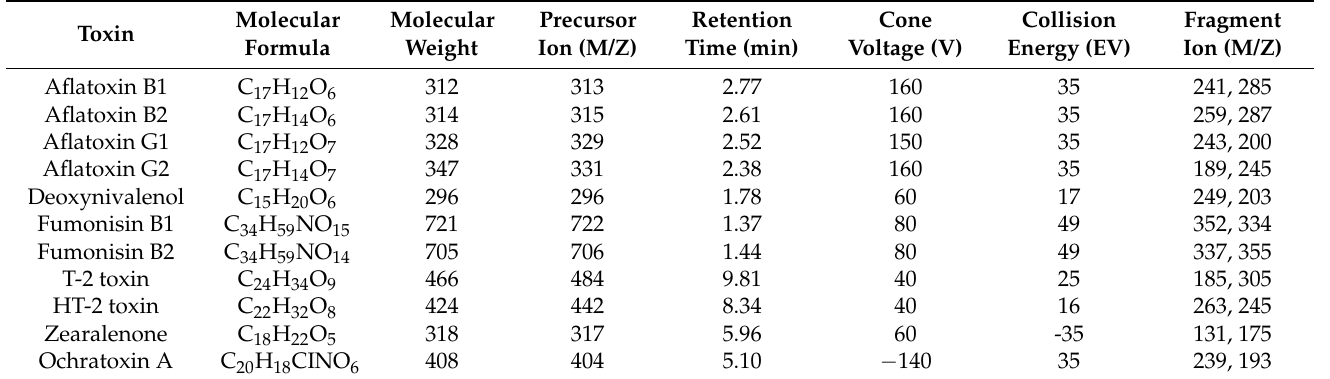
Table 3. Mass spectrometry conditions for LC-MS/MS detection of 11